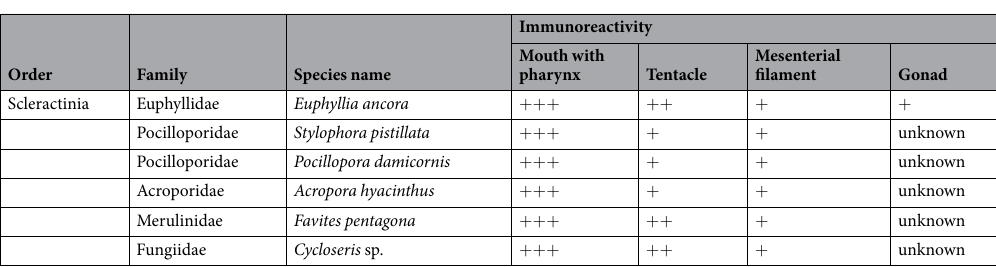
Table 2. Distribution of GLWamide neurons in scleractinian corals as assessed by immunohistochemical analysis. The levels of number of cells exhibiting immunoreactivity were defined as four grades: many ( +++ ), moderate ( ++ ), a few ( + ), and negative